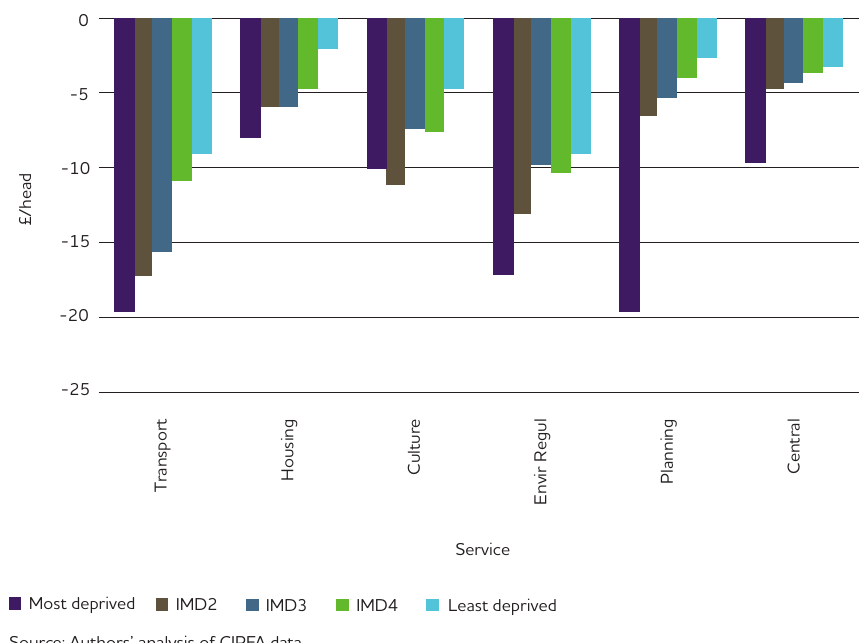
16 The cost of the cuts: the impact on local government and poorer communities